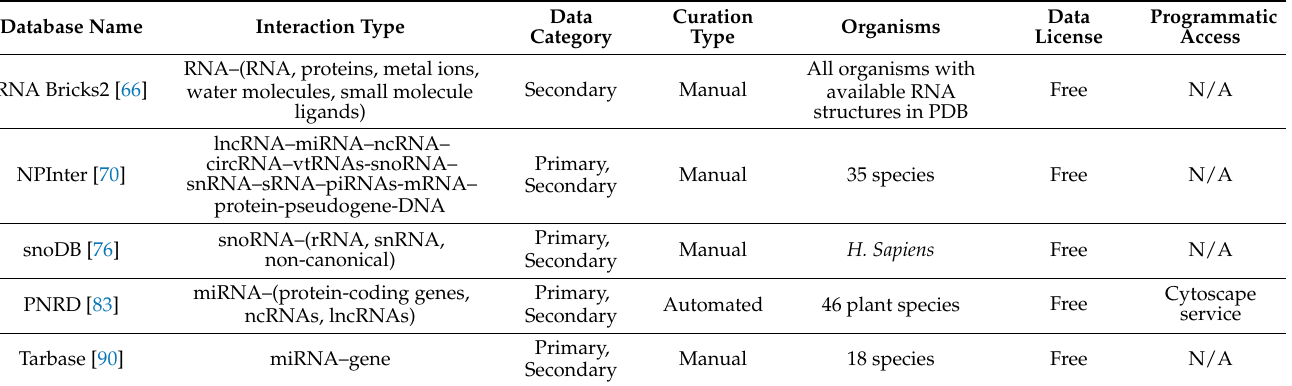
Table 2. RNA interaction